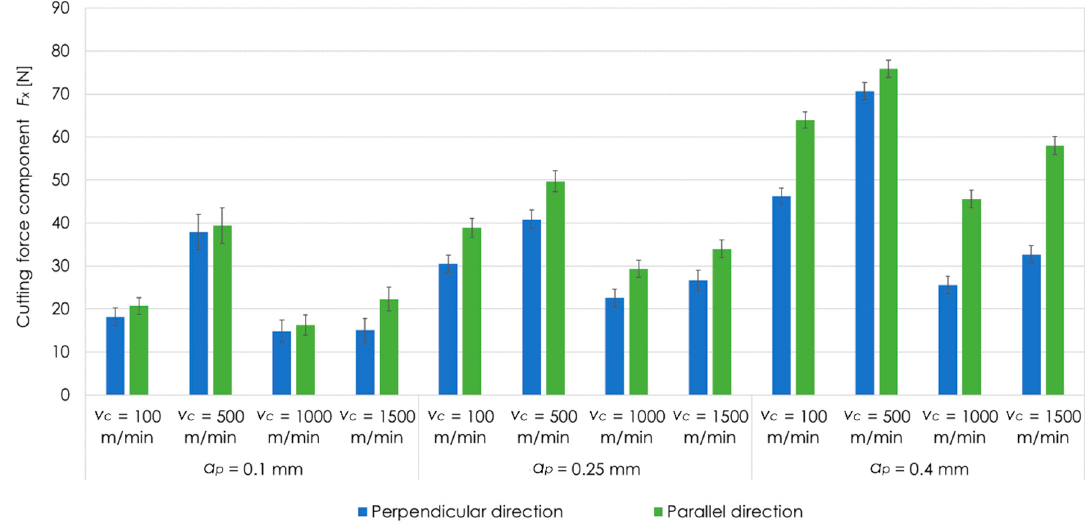
Figure 6. Cutting force component F x for EN AW-2017A T451 aluminium alloy, tested cutting speeds v c , depths of cut a p as well as perpendicular and parallel milling direction in relation to the rolling direction.